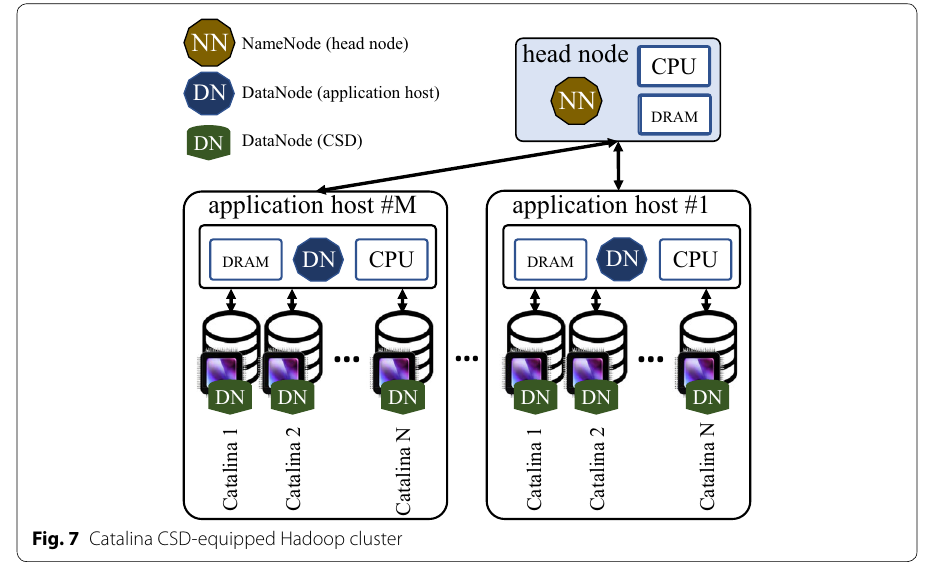
Fig. 7 Catalina CSD-equipped Hadoop cluster